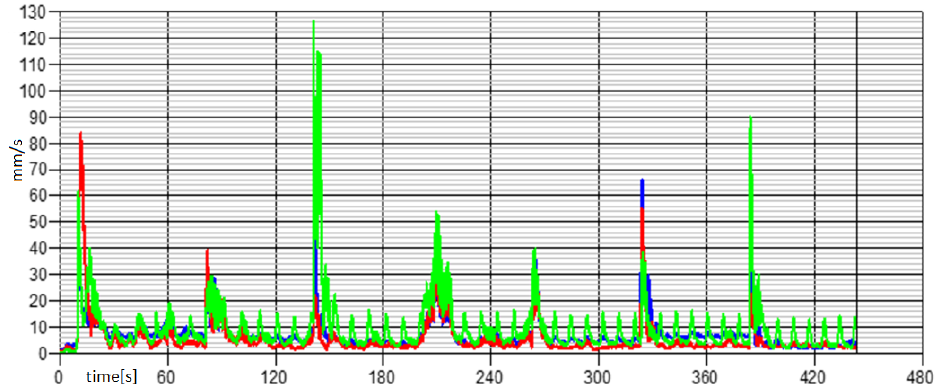
Table 2. Data obtained for the bearings of each vehicle at different engine rpm. Tractor